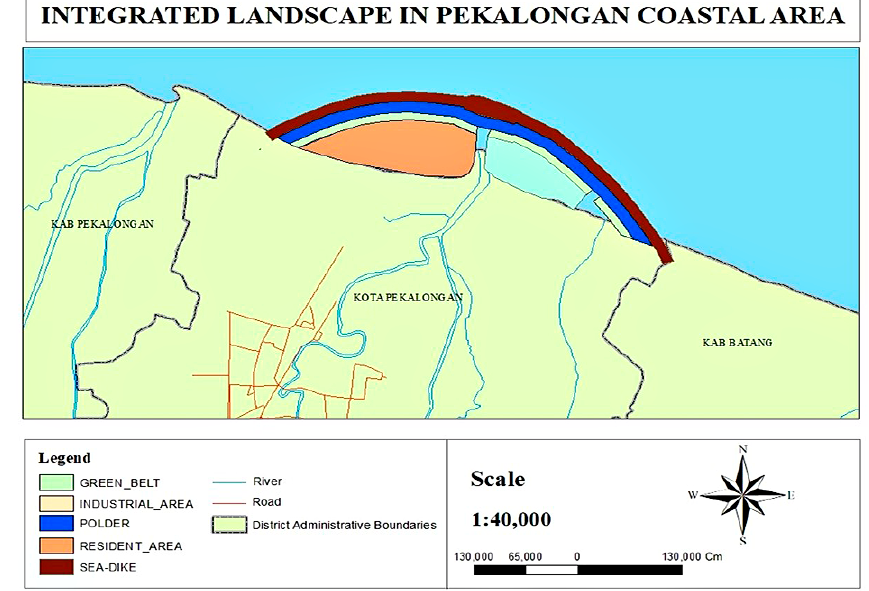
Figure 19. Layout Map of Pekalongan Tidal Floods Management Concept Design (Alternative 2)